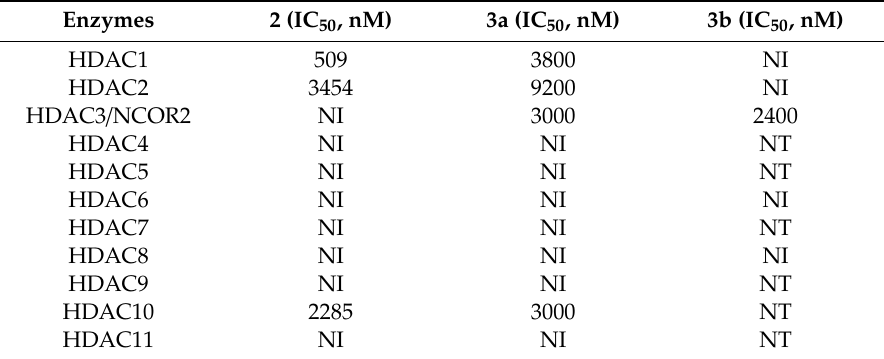
Table 2. HDAC isoform inhibition activities of 2 and 3a , b .